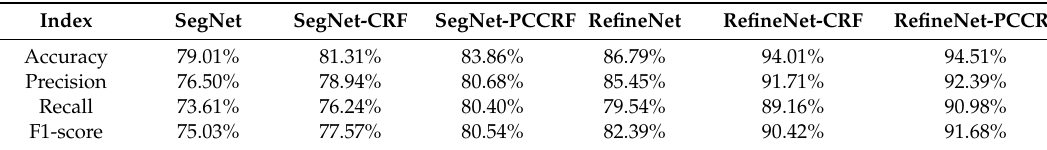
Table 3. Comparison of the six